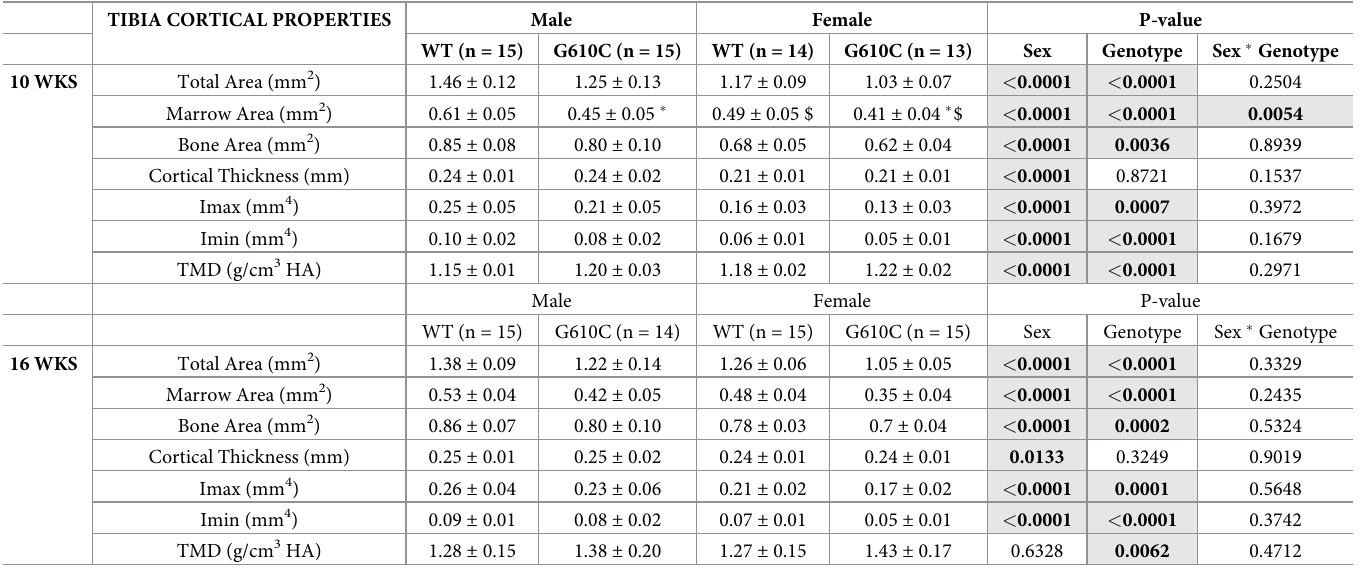
Table 2. Tibia cortical properties at 10 and 16 weeks, with p-values from 2-way ANOVA. TIBIA CORTICAL PROPERTIES